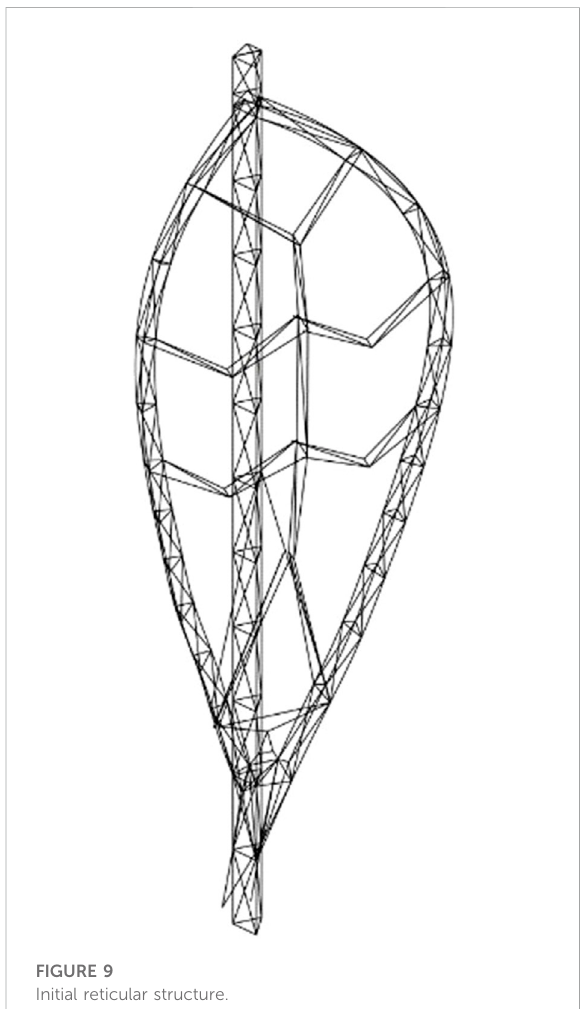
FIGURE 9 Initial reticular